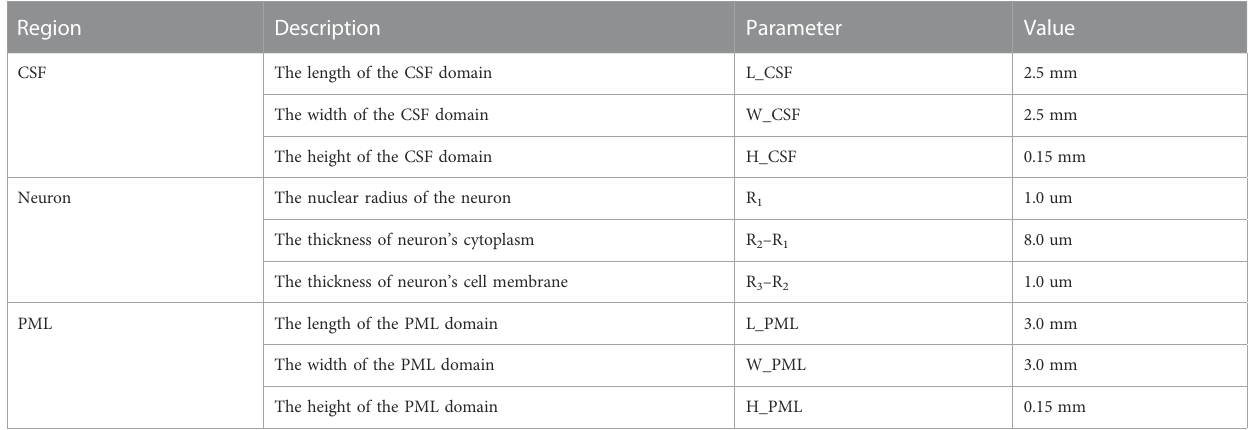
TABLE 1 Dimensions of the simulation domain geometry.